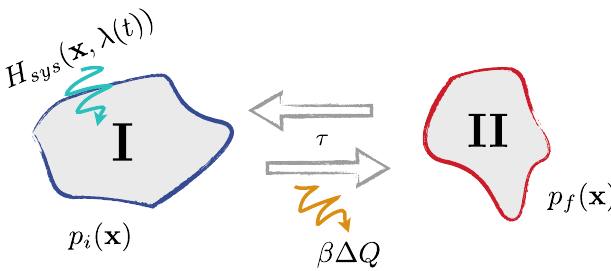
FIG. 2. An arbitrary nonequilibrium macrostate for the system of interest is constructed as the probability density p the microstates x when the system is prepared by a controlled procedure to have some macroscopic property I . The system is externally driven for a period of duration τ by a time-varying field x ; λ ð t ÞÞ while in contact with a thermal bath of inverse H sys ð temperature β that absorbs heat Δ Q . Afterwards, one may ask whether the system now has a new macroscopic property II ; if so, the new probability distribution over microstates is implicitly x Þ d x given by p f ð